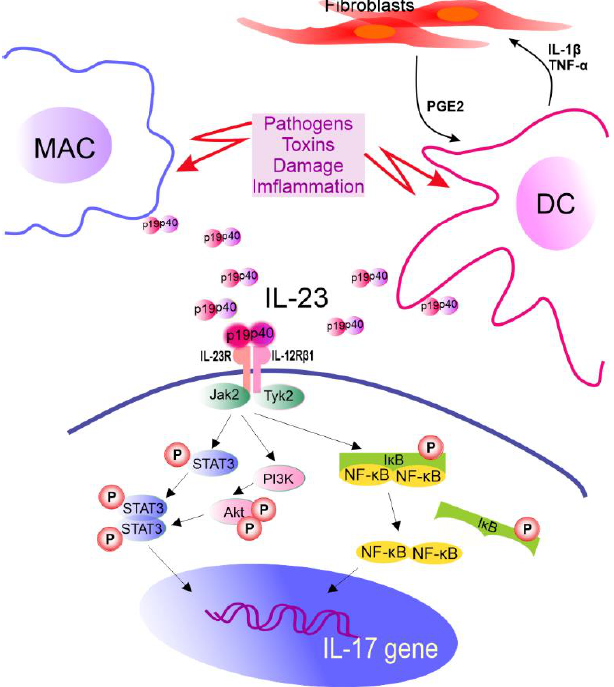
Figure 2. The role of IL-23 in IL-17 gene expression. IL-23R pairs with IL- 12Rβ1 forming IL -23R complex required for IL-23 signaling. This receptor is constitutively associated with Janus kinase 2 (Jak2) and Tyrosine kinase 2 (Tyk2) which are activated after ligand biding, leading to STAT3 phos- phorylation (P). Other molecules in IL-23 signaling cascade are also identified. MAC — macro-